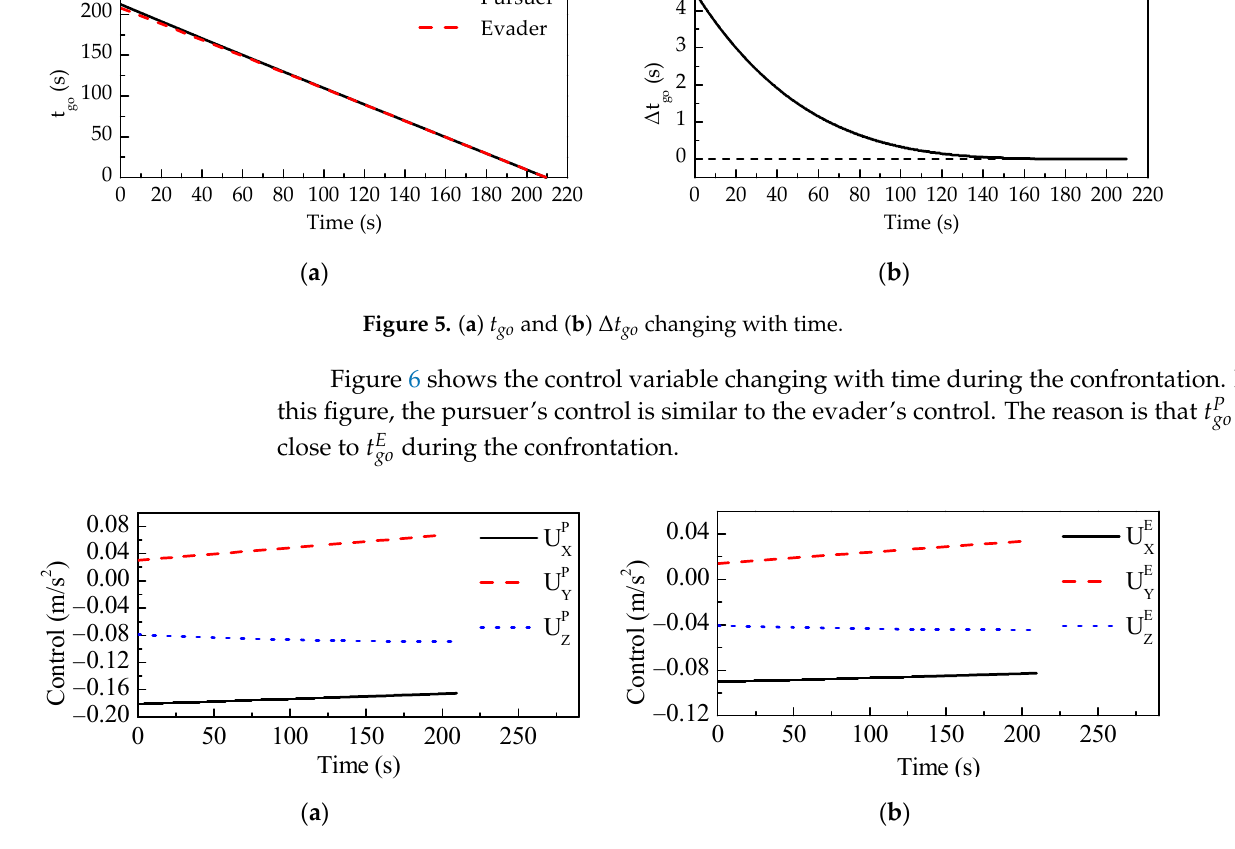
Figure 6. The control variable of ( a ) the pursuer and ( b ) the evader changing with time.